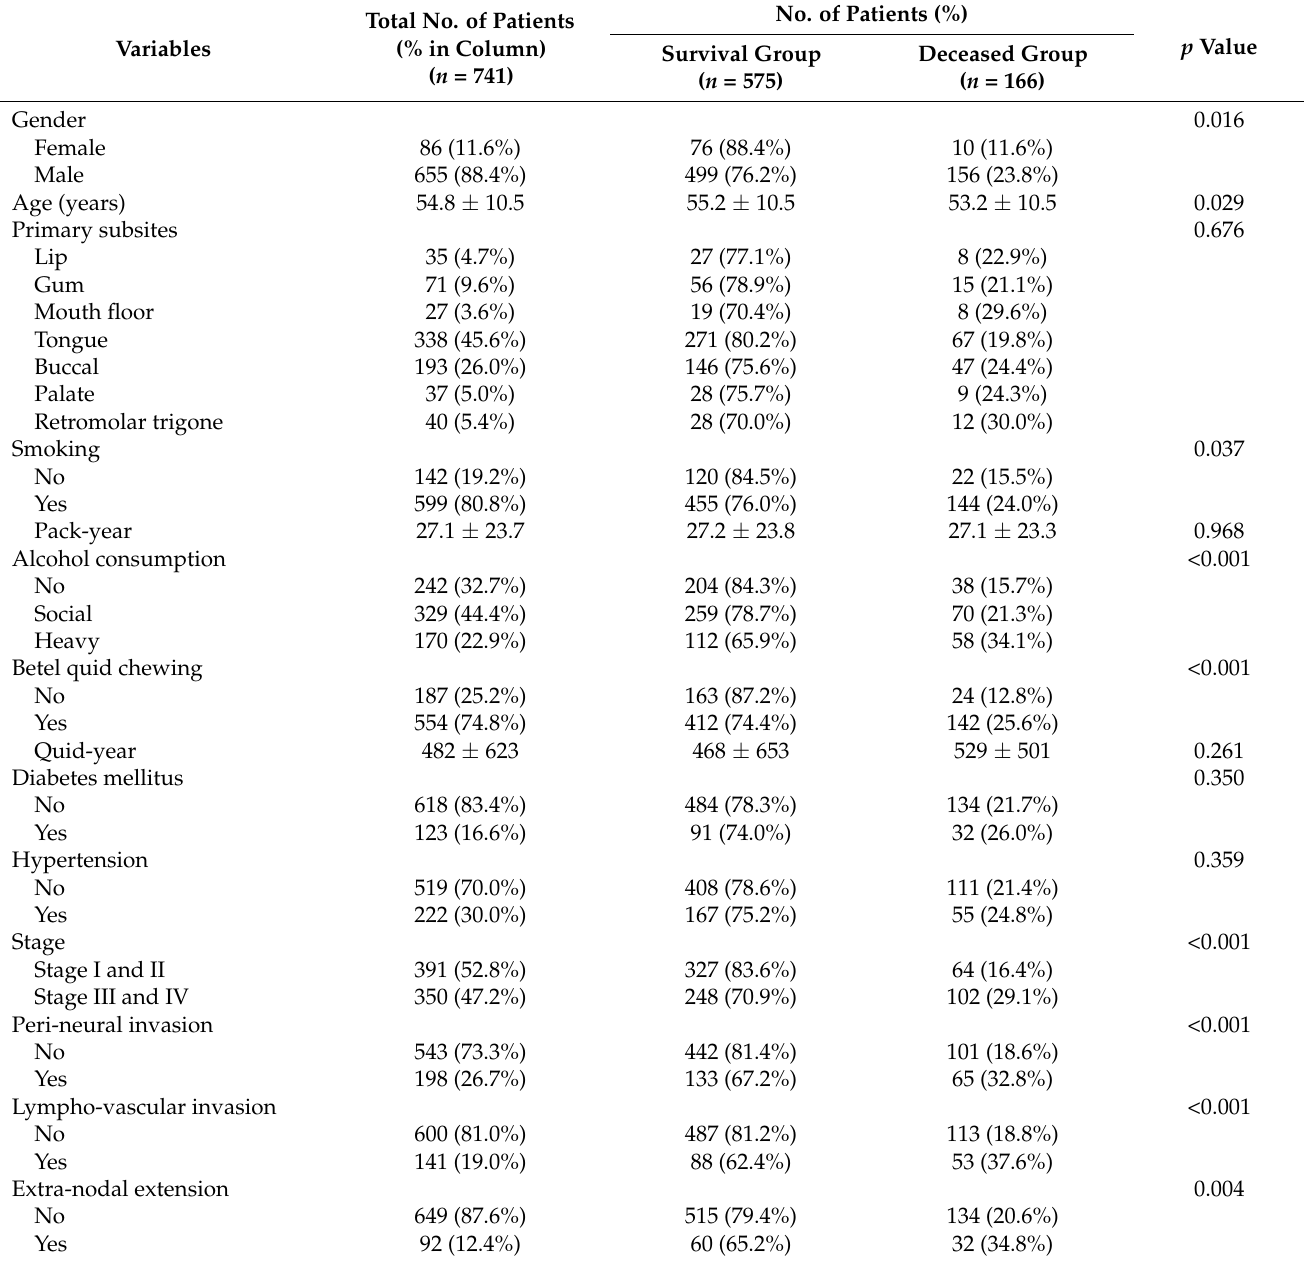
Table 1. Descriptive statistics of oral cavity cancer patients based on survival